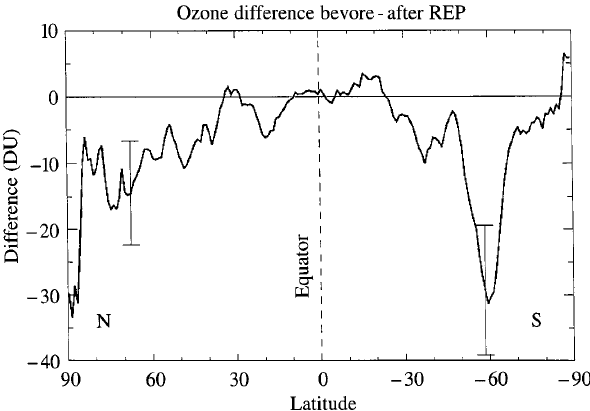
Fig. 4. The meridian profile of the ozone decrease after the REP events. The vertical bars are